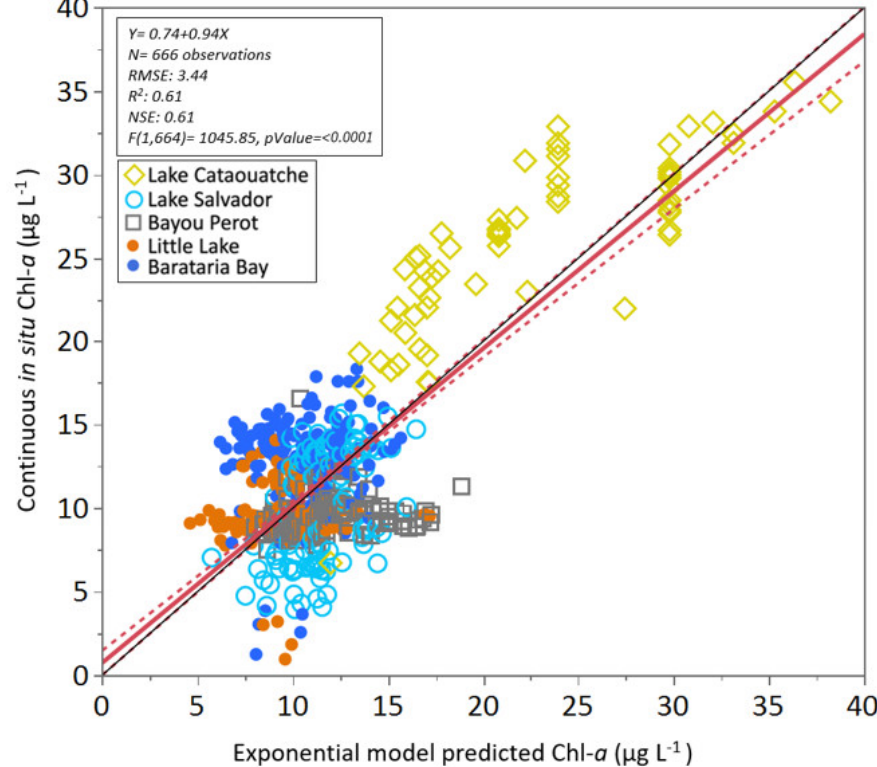
Figure 8. Linear regression between the model predicted continuous in situ Chl- a and the validation data subset (see Section 2). The solid black line shows the 1:1 relationship. The solid bold red line is the regression line; dashed red lines represent the 95% confidence interval.